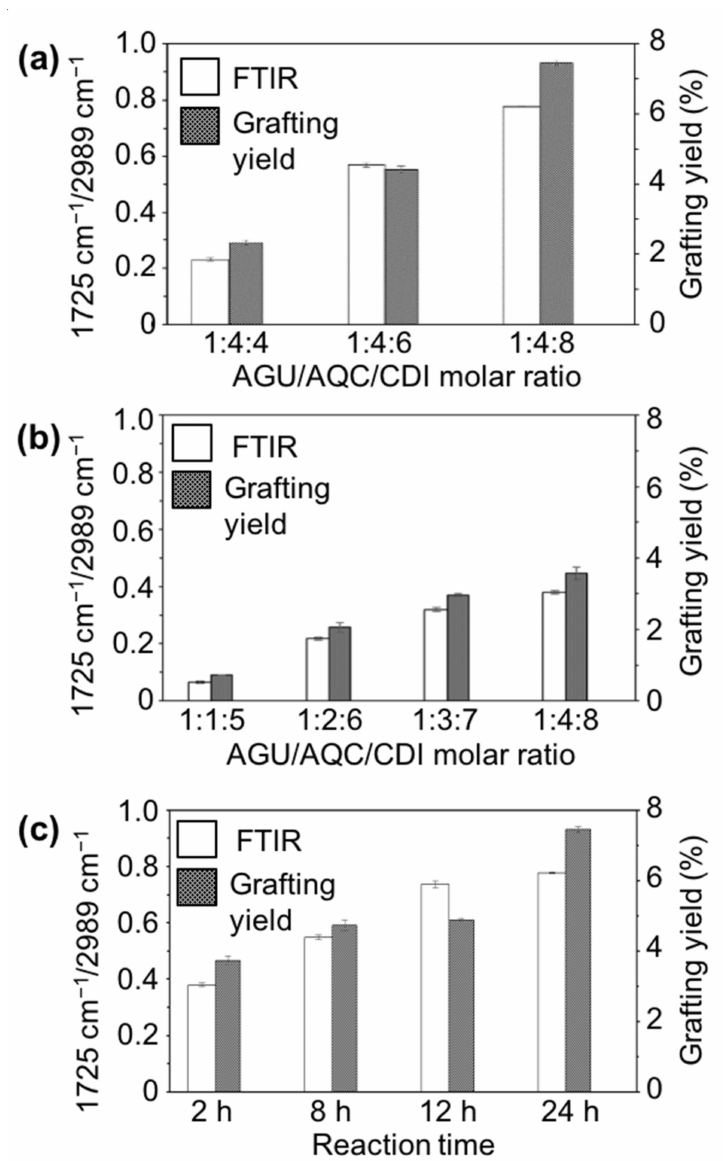
Figure 3. Impacts of reaction conditions on ester formation, as shown in the ratios of 1725 cm − 1 / 2989 cm − 1 and grafting yields: ( a ) impact of ratios of AQC / CDI (AGU / AQC unchanged), ( b ) impact of ratios of AGU / AQC / CDI, and ( c ) impact of reaction